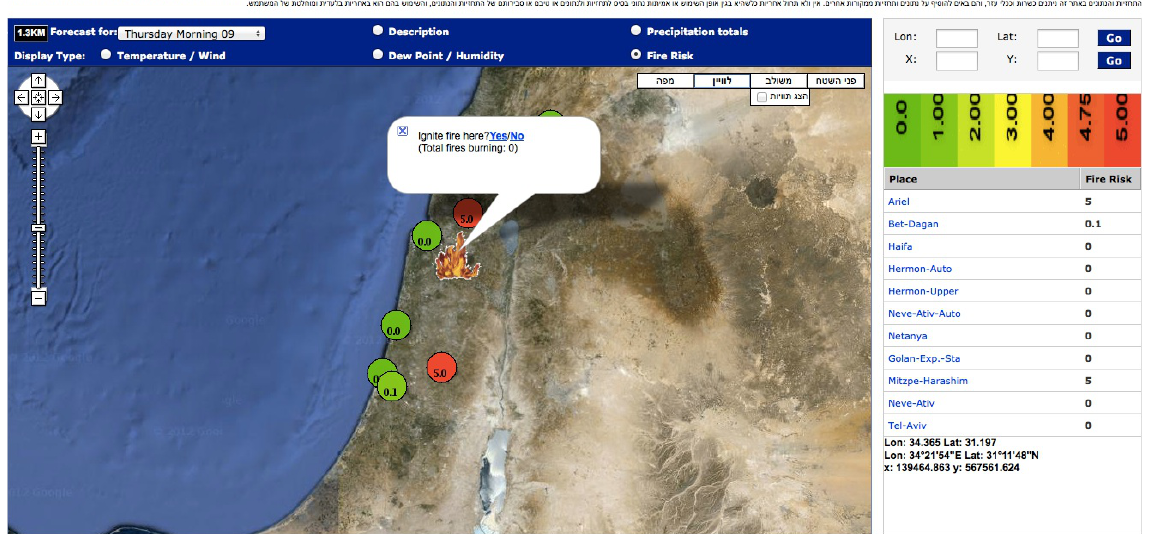
Figure 13. Interactive fire ignition. Fig. 11. Interactive fire ignition.